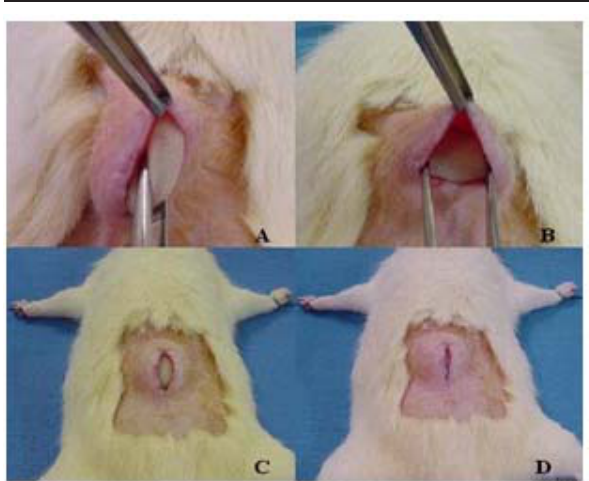
FIGURE 1 – Polyurethane-coated silicone implant being placed between the aponeurosis and the subcutaneous tissue (A, B, C and